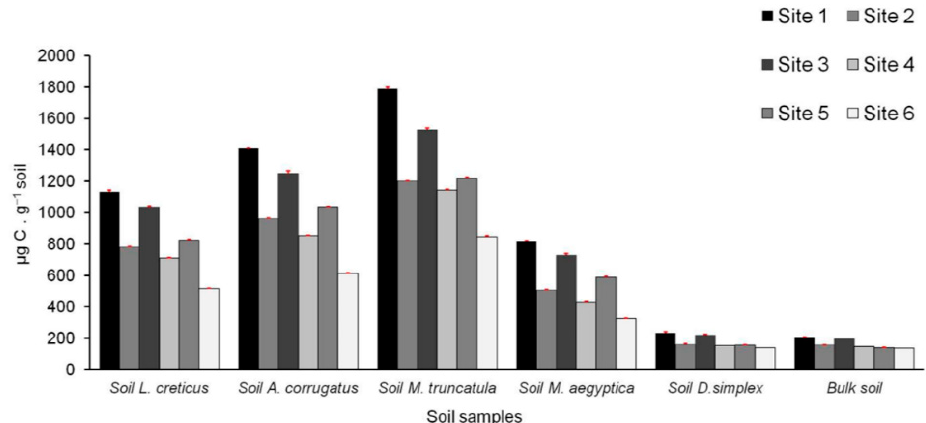
Figure 6. Microbial biomass carbon (Cmic) in the different sampled soils. Data are reported as mean (±SE) of three replicates per sample.